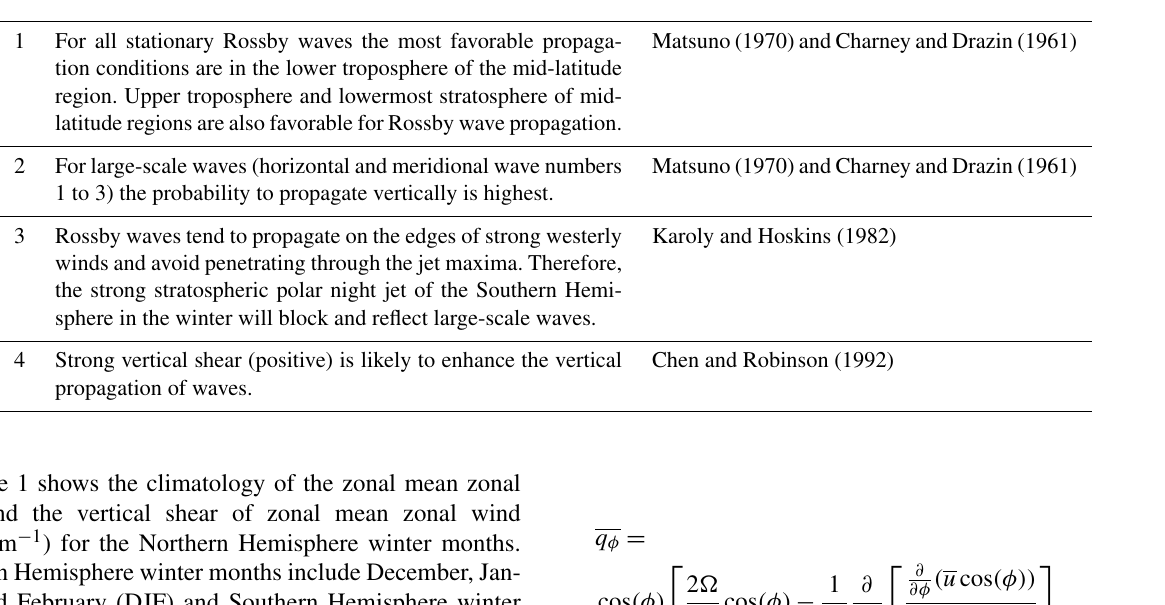
Table 1. A summary of known facts about stationary Rossby wave propagation. Any diagnostic tool that attempts to provide a climatology of stationary Rossby wave propagation conditions should be consistent with these criteria. These criteria refer only to the linear